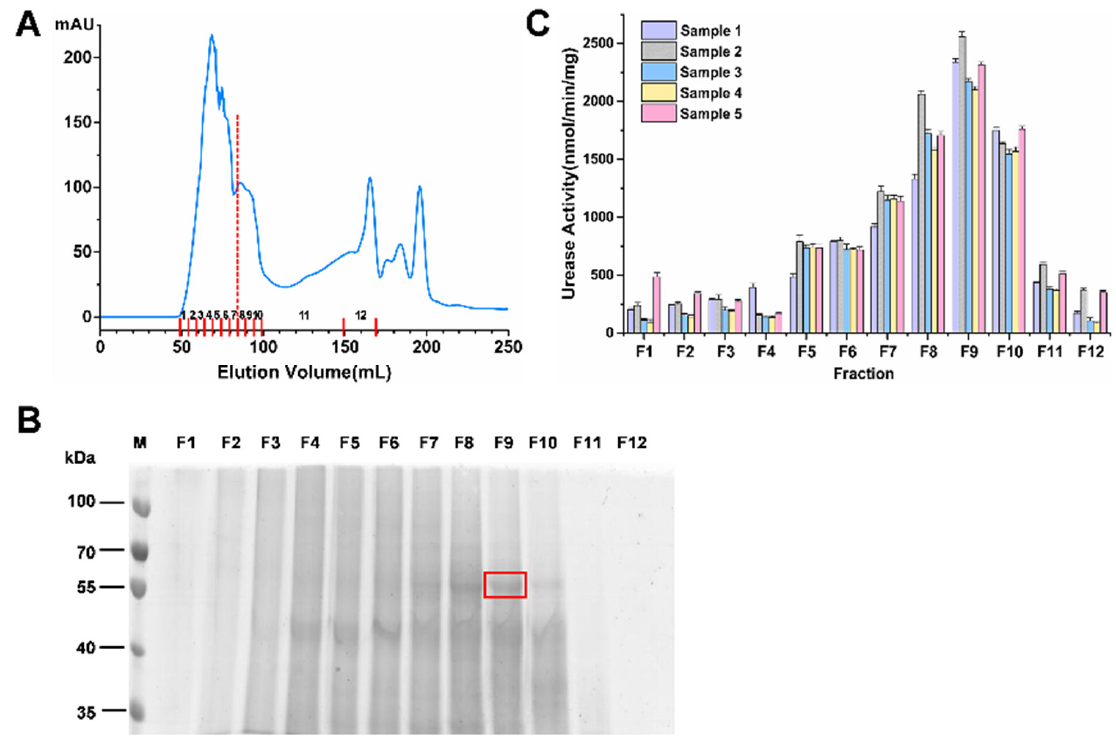
Figure 2. Purification of proteins with high urease activity. ( A ) Gel filtration chromatography map of proteins with high urease activity. The distance between the red lines represents the elution volume of each fraction. ( B ) SDS-PAGE gel of purified 12 fractions (F1–F12) from Sample 5. Protein lanes in the red box were isolated for metaproteomic analysis. ( C ) Urease activities of purified 12 fractions (F1–F12) from all samples.